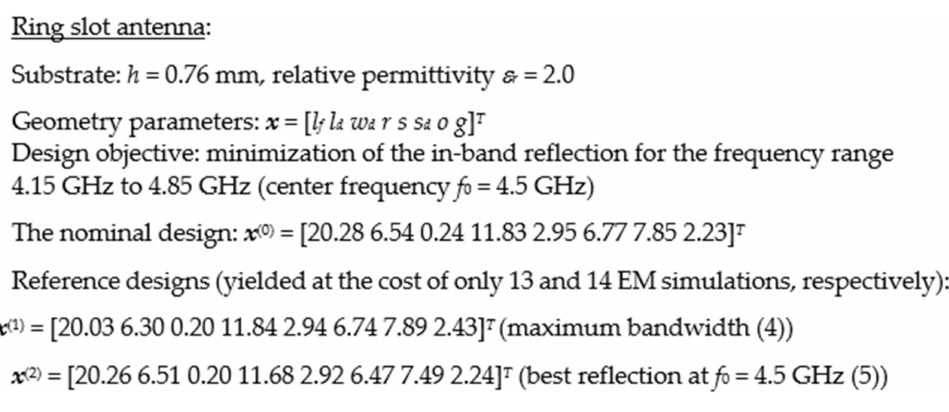
Figure 8. Description of the ring slot antenna of Figure 7 [67]. Table 2. Yield optimization of the ring-slot antenna of Figure